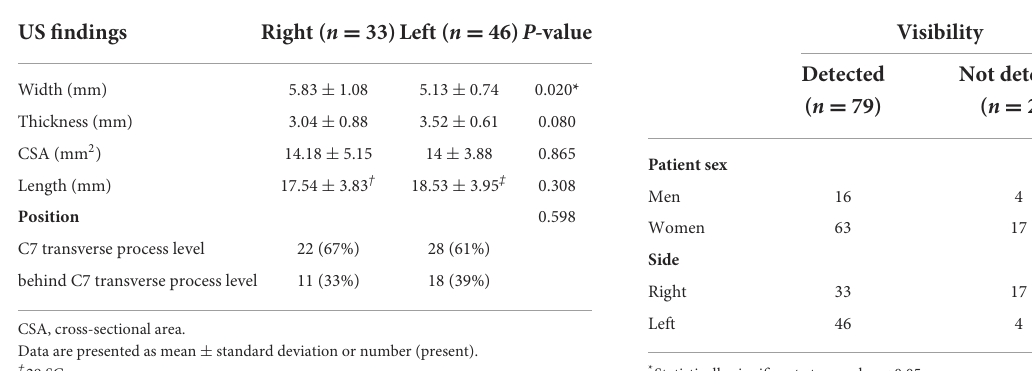
TABLE 1 Comparison of US findings between the right and left sides. TABLE 2 Factors related to SG